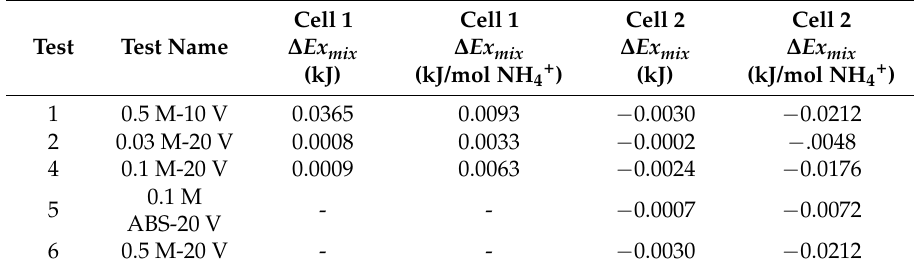
Table 6. Exergy of mixing, ∆ Ex mix , in kJ at the end state of the test calculated in Cell 1 and 2, respectively. The mixing exergy is given as a total and as exergy per mol of NH 4+ . Some data from Cell 1 is missing for test 5 and 6.